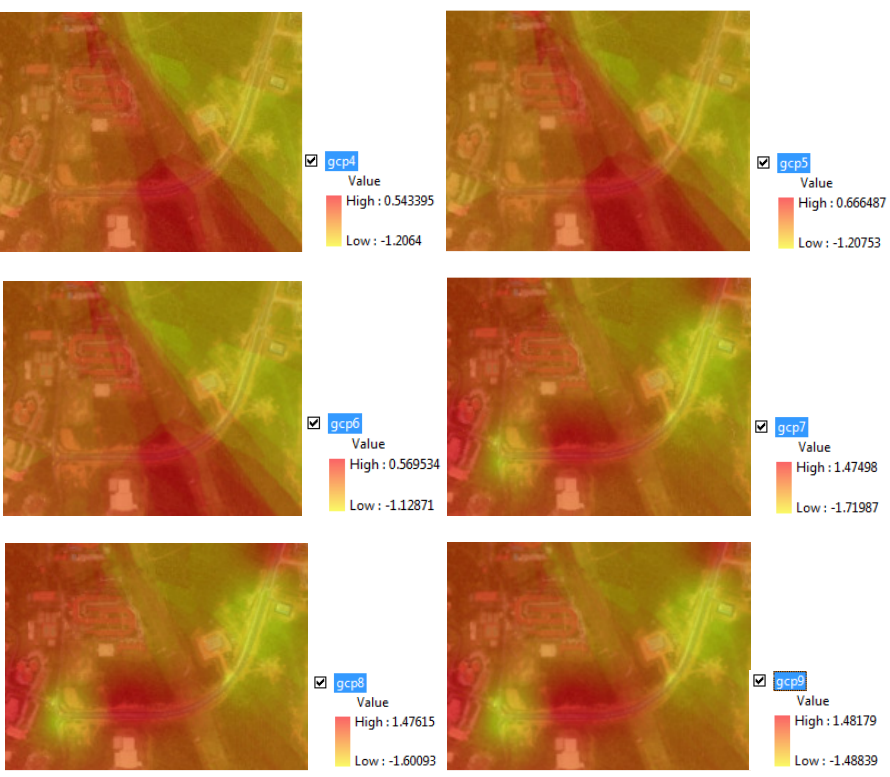
Figure 6. Results on Elevation Error for RTK GPS from Known GPS Station (10 minutes) based on different GCP configurations.